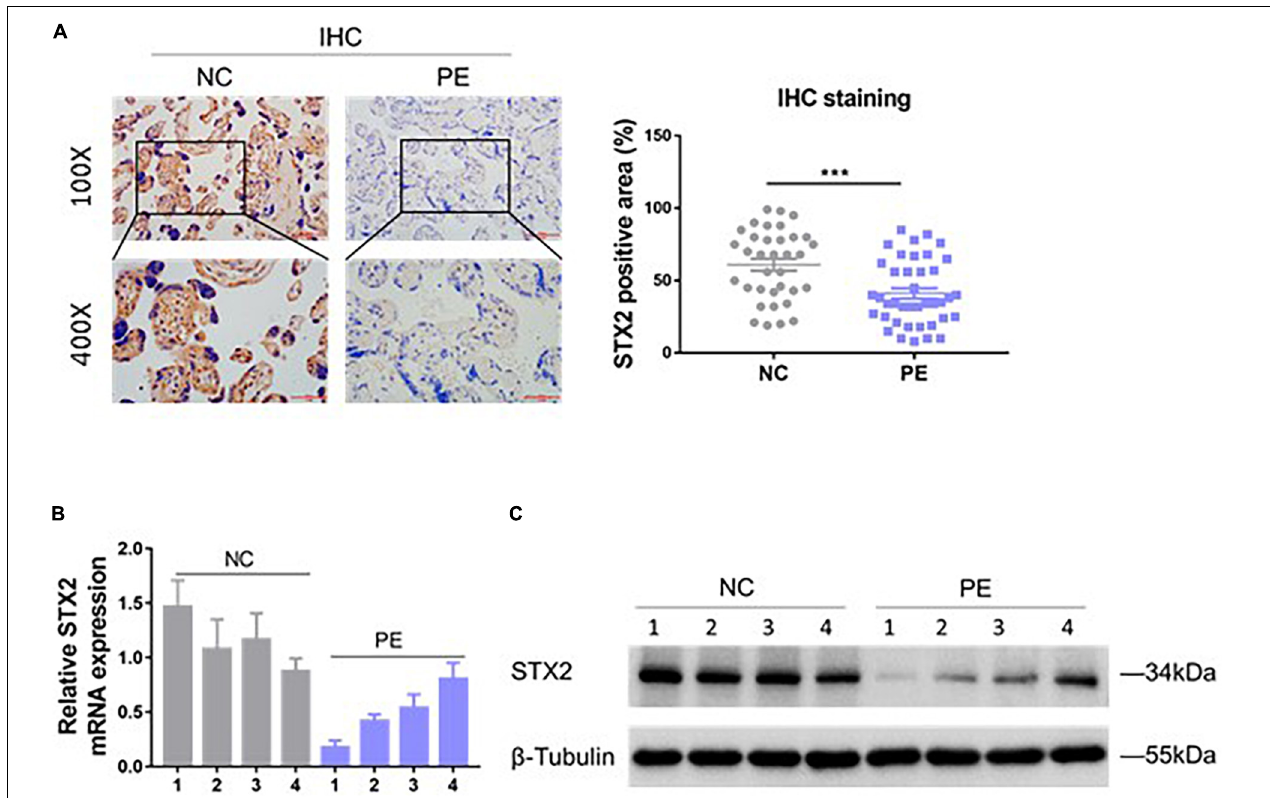
FIGURE 1 | STX2 is downregulated in the placenta of PE pregnancies. (A) Representative images of IHC staining of STX2 in normal control (NC; n = 35) tissues and PE ( n = 40) tissues. Scale bar: 100 µ m (100 × ); 50 µ m (400 × ). Student’s t -test: *** P < 0.001. (B) Relative STX2 mRNA levels of placenta tissues from pregnant women with PE or normal control pregnancy (NC) as detected by qRT-PCR ( n = 4/group). (C) Relative STX2 protein levels of placenta tissues from pregnant women with PE or normal control pregnancy as detected by western blot ( n = 4/group). β -Tubulin was used for normalization. All the experiments were repeated three times